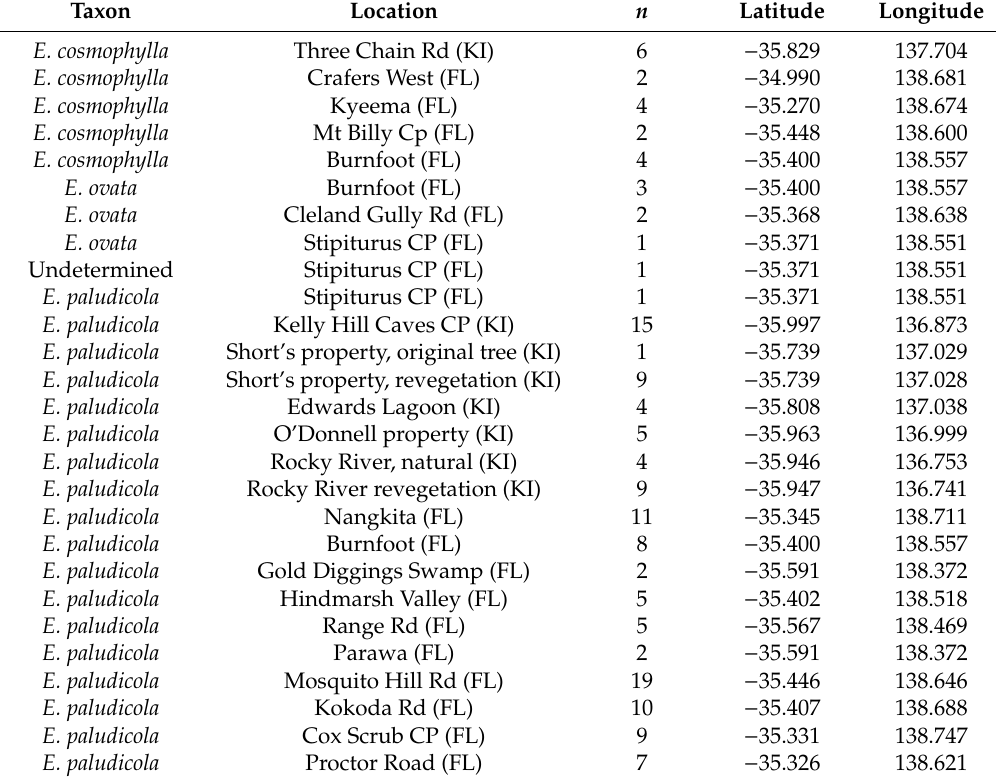
Table 1. Taxa and locations of tested